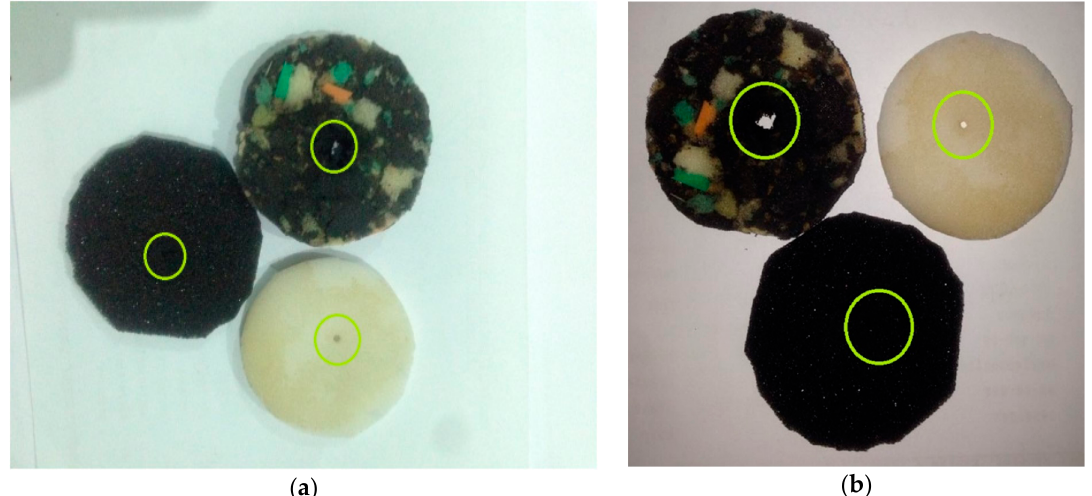
Figure 19. ( a ) Samples tested with lightning impulse discharge test; ( b ) Samples tested with disruptive discharge test.